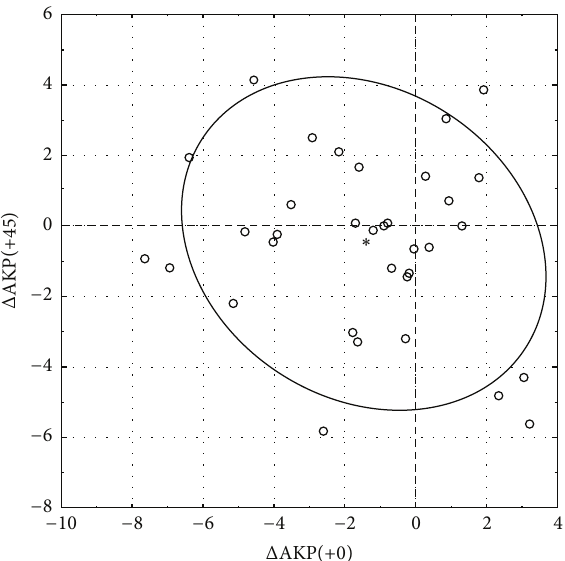
Figure 1: Surgically induced astigmatism is shown as pairs of polar values for the 6mm Intacs SK implantation. The asterisk denotes the combined mean polar values, and the 95% bivariate confidence ellipse is shown. Δ AKP (+0) = AKP (+0) postop − AKP (+0) preop ;